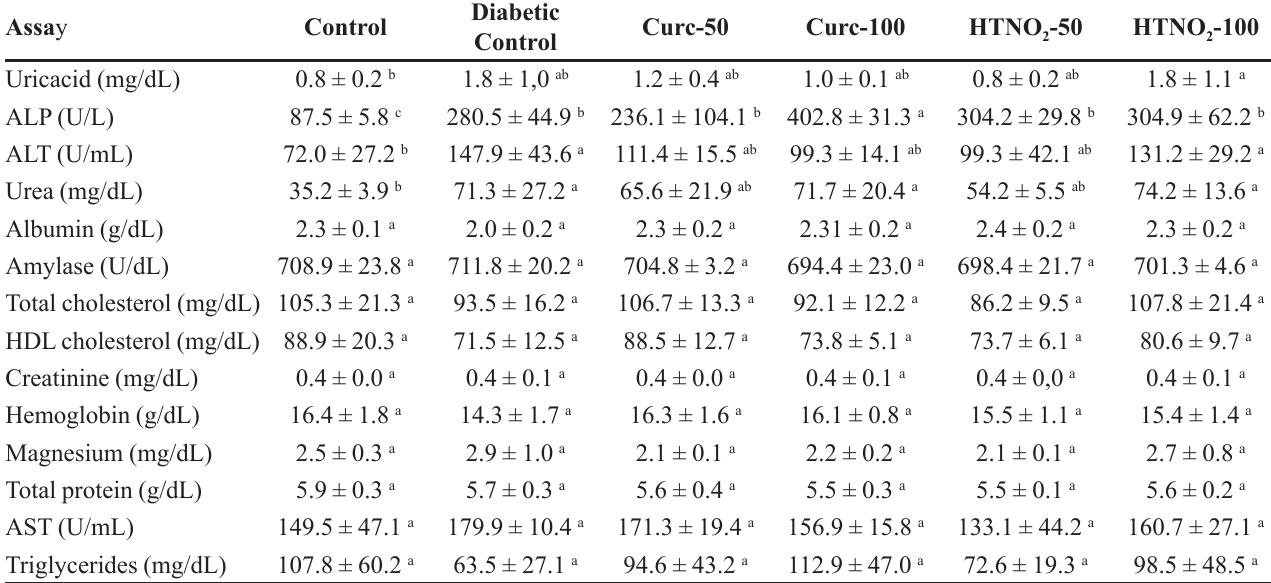
TABLE VI - Results of biochemical assays ofratsblood samples Assa